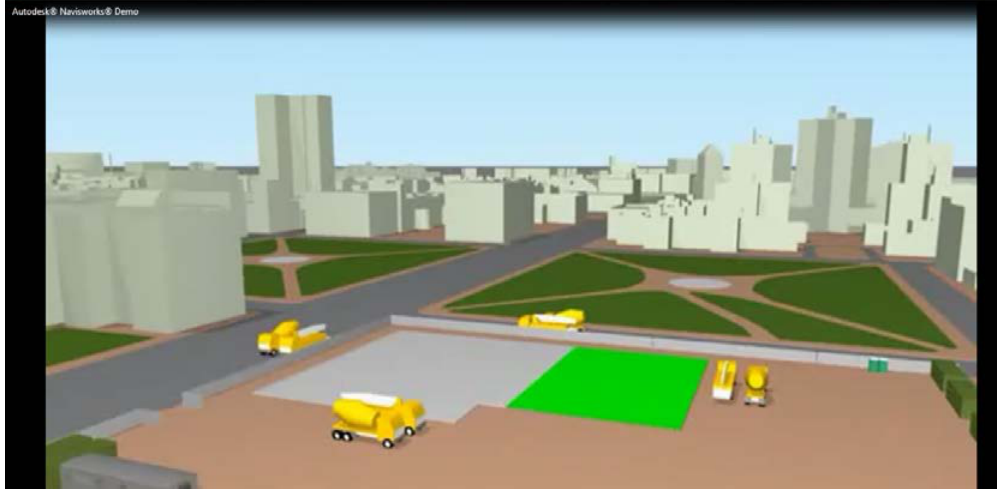
Figure 4: A slab model showing pour ‘cut’ (in light